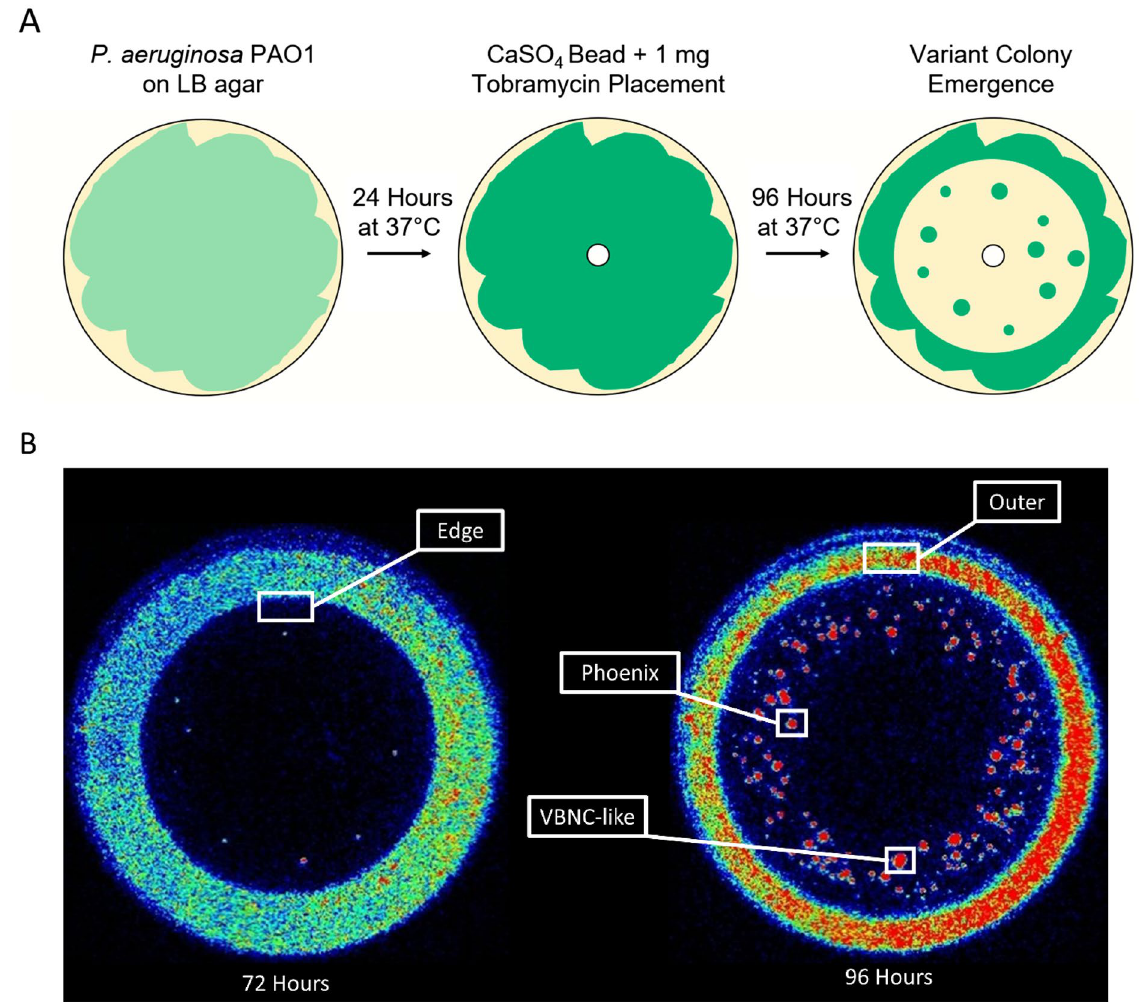
Figure 1. Isolation of P. aeruginosa colony variants for assaying the genome and gene expression. ( A ) Diagram of the experimental methods for obtaining variant colony emergence for P. aeruginosa PAO1 with tobramycin. ( B ) In vitro imaging system (IVIS) images of representative phoenix colony plates show areas of bacterial sampling. Seventy-two hours post tobramycin bead placement, samples were taken from the edge of the zone of clearance (ZOC) where phoenix colonies would be expected to arise the following day after continued incubation. Ninety-six hours post tobramycin bead placement, samples were taken from phoenix colonies, VBNC-like colonies, and the outer background lawn. Additionally, samples were taken from bacterial lawns grown for 72 h that had not been exposed to antibiotics to be used as comparative controls. Red indicates high levels of metabolic activity, blue indicates low levels of metabolic activity, black indicates no metabolic